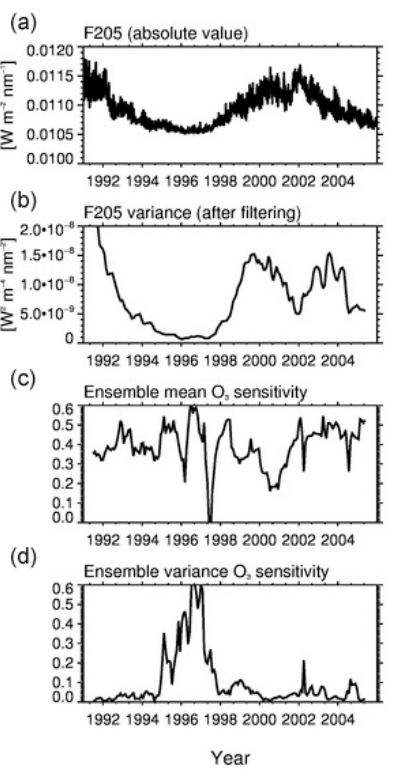
Figure 9. Digitally filtered (b) F205 variance time series, (c) en- semble mean ozone sensitivity and (d) ozone sensitivity ensemble variance time series at 3hPa computed over a 1-year running win- dow. Each window is sliding for 1 month at each step. (a) The F205 index time series is reproduced on the top panel for clarity.